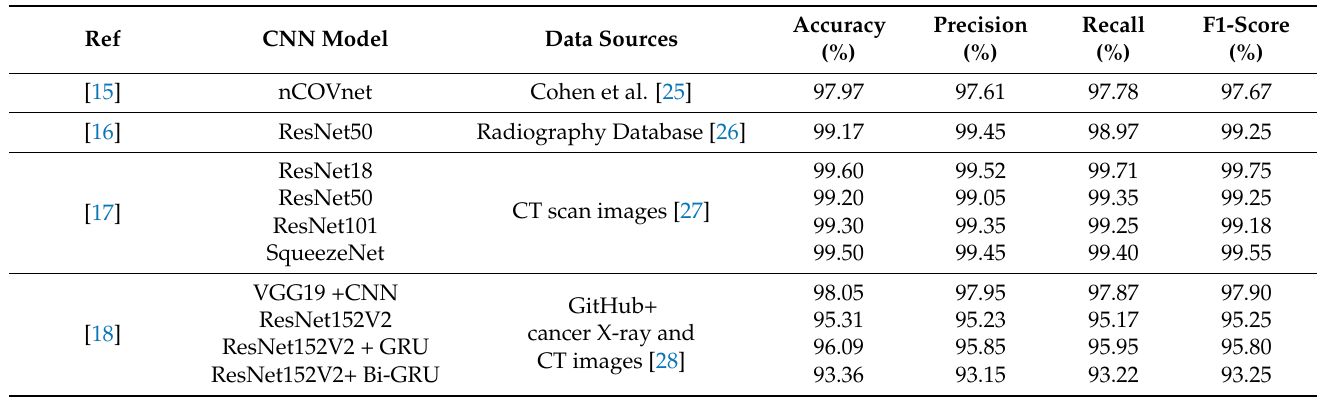
Table 6. The results obtained compared to state-of-the-art methods.